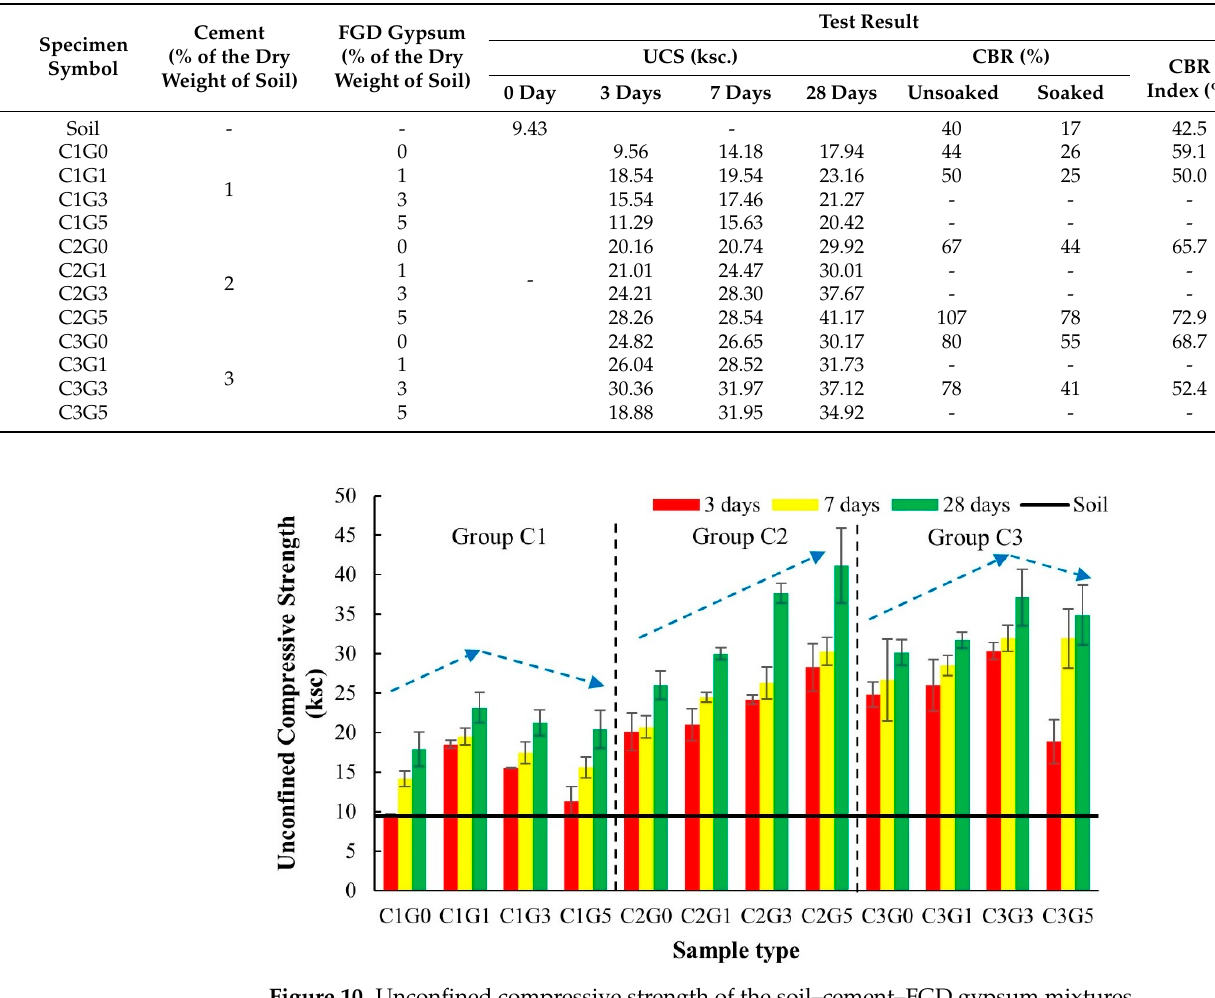
Figure 10. Unconfined compressive strength of the soil–cement–FGD gypsum mixtures.